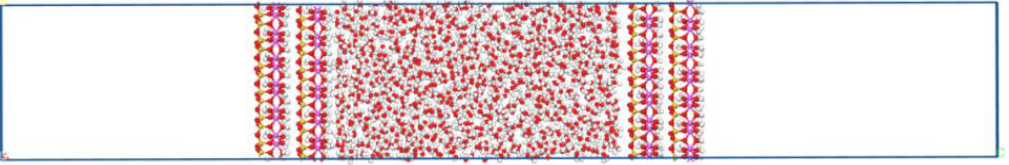
Figure 14. Model for an NVT simulation of water competitive adsorption on the T and O surface of kaolinite at 298 k. kaolinite at 298